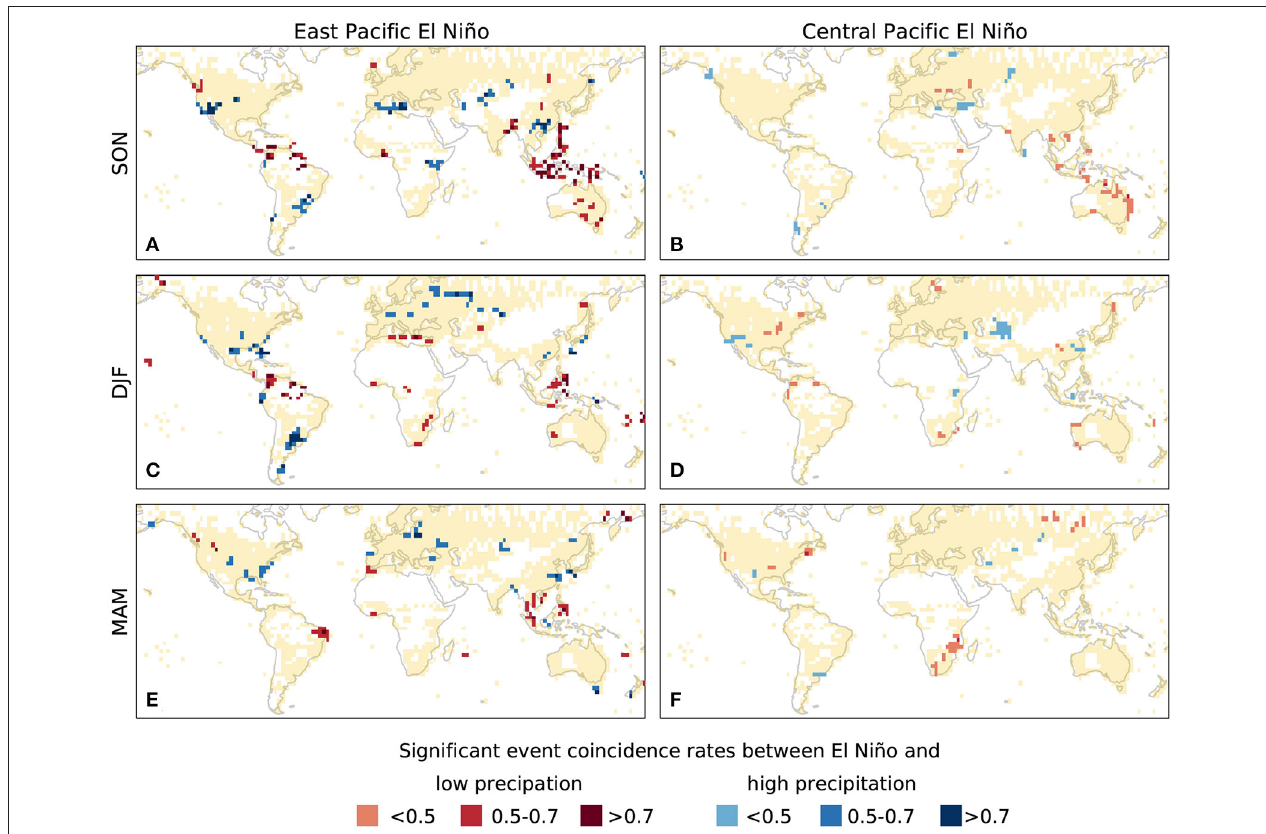
FIGURE 3 | Statistically significant event coincidence rates (ECR) between EP (A,C,E) and CP (B,D,F) El Niños and very dry (red squares) or very wet (blue squares) conditions for the three seasons SON, DJF, and MAM. Dry/wet periods are defined by seasonal precipitation sums below/above the 20th/80th percentile of all years from 1951 to 2016. Only significant clusters of at least two adjacent grid-cells are shown. Different shades of red/blue indicate increasing magnitudes of significant ECR between the respective El Niño events and strong/weak seasonal precipitation. Yellow areas indicate grid cells with non-significant event coincidence rates. White areas over land indicate insufficient quality of the GPCC dataset (i.e., grid cells excluded from our